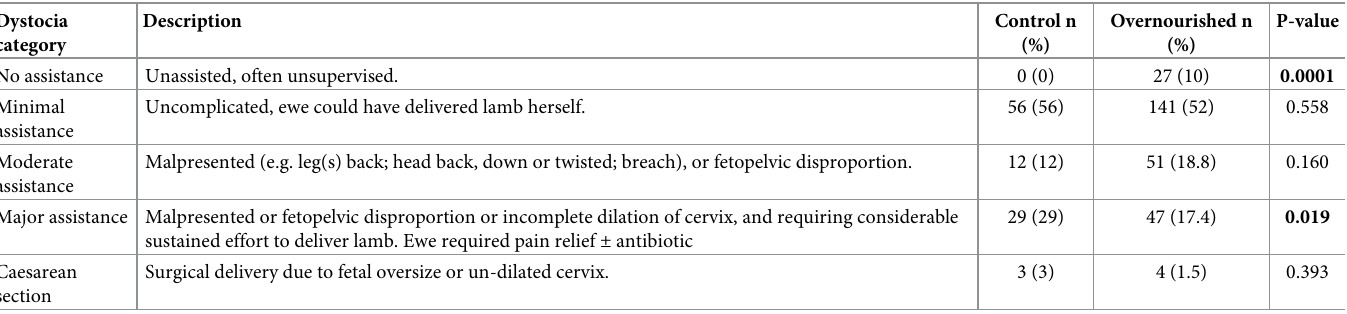
Table 2. Incidence of dystocia in singleton bearing adolescent ewes offered a control intake or overnourished throughout